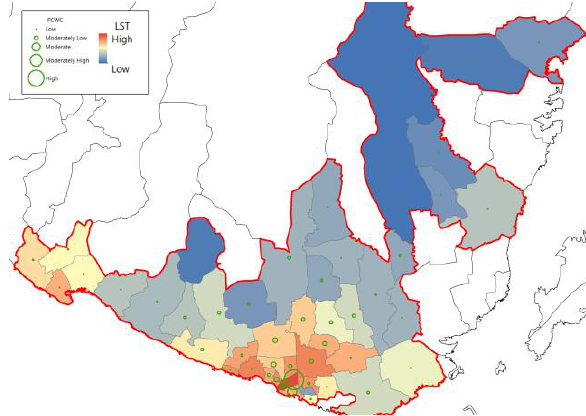
Figure 7. Spatial variation of barangay-averaged LST and PCWC data of the 49 barangays for March 2017